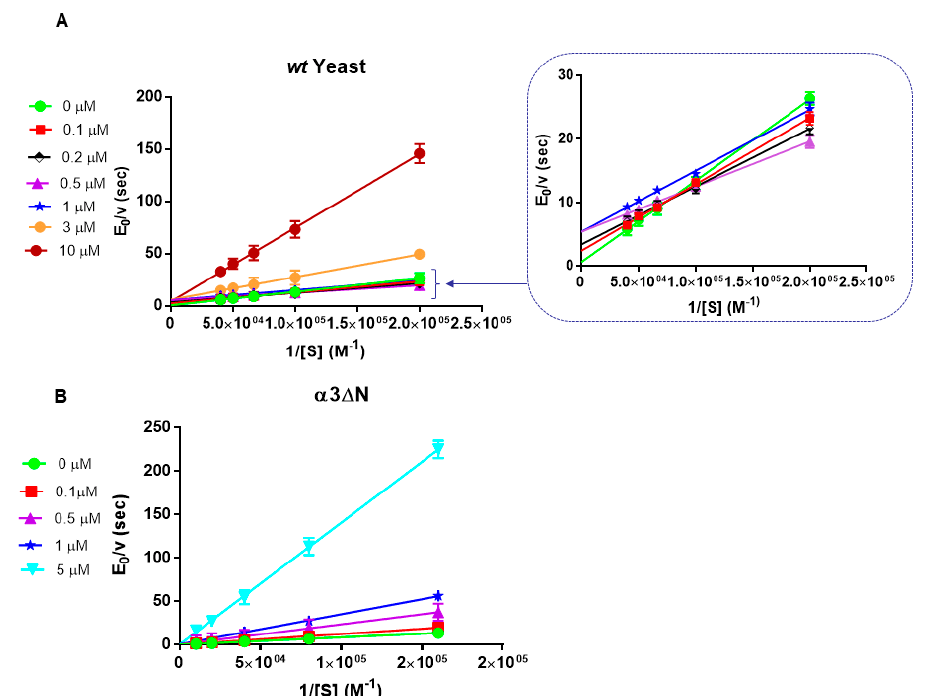
Figure 4. Lineweaver-Burk plot of the e ff ect of Tris-T4 wt y20S proteasome (panel A ) and on the yeast α 3 ∆ N mutant (panel B ). Various symbols refer to the di ff erent Tris-T4 concentrations, ranging from 0 to 10 µ M (panel A ) and from 0 to 5 µ M (panel B ). Inset refers to data for wt y20S at higher substrate concentrations to magnify the activation e ff ect.